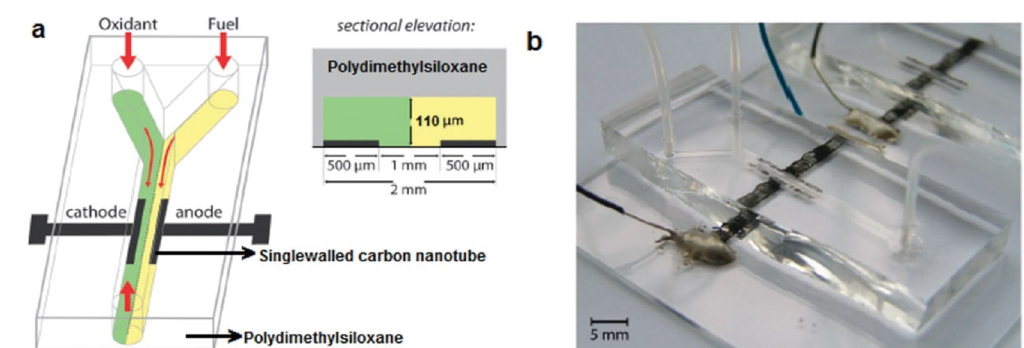
Fig. 12. (a) Scheme of the microfluidic Glucose biofuel cells. Dimensions are provided in the sectional elevation. (b) Photograph of the microfluidic Glucose biofuel cells